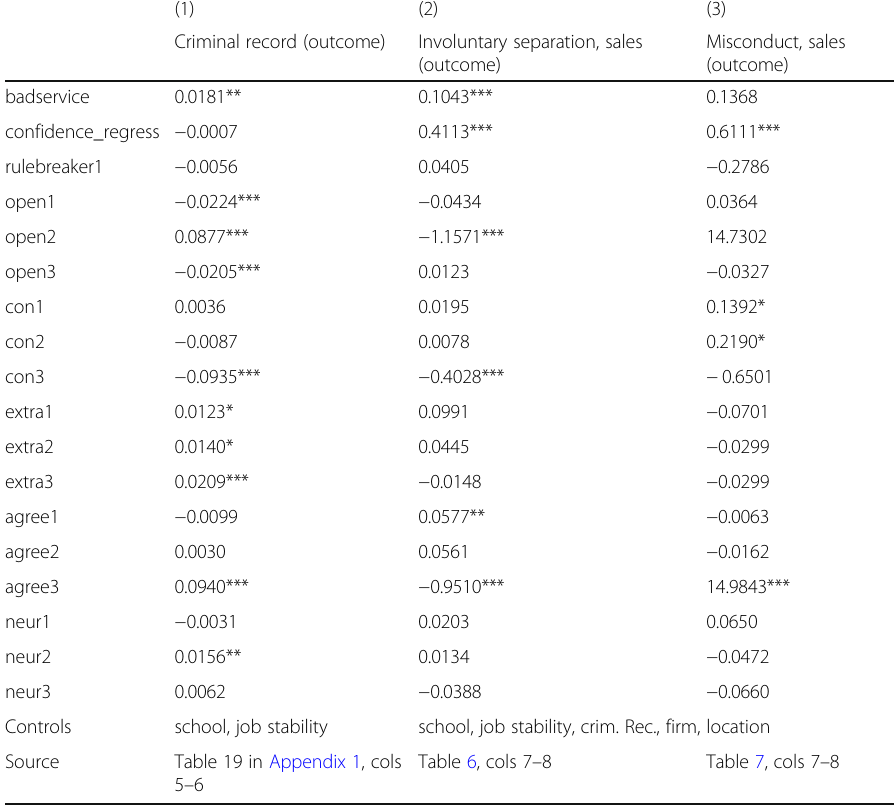
Table 17 Correlates of poor job outcomes, correlates of criminal record, and characteristics of sales workers with criminal